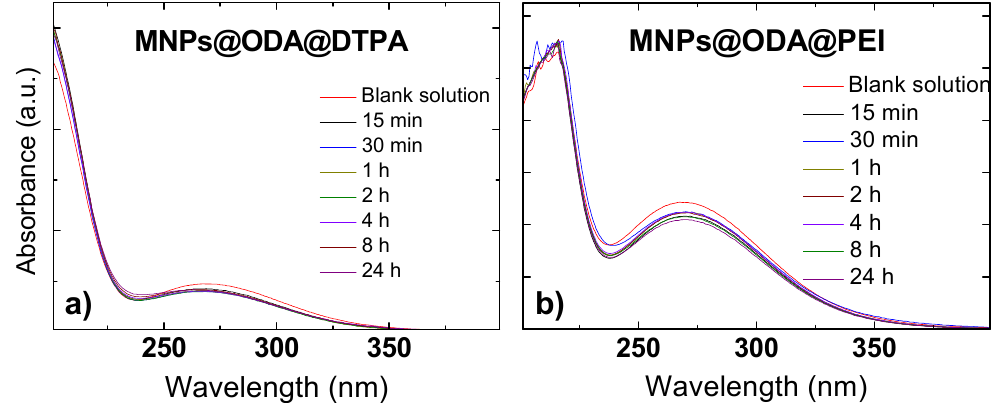
Figure 5. UV–Vis titration of the blank solution (Cu(NO 3 ) 2 ) with (a) (MNPs@ODA coupled with